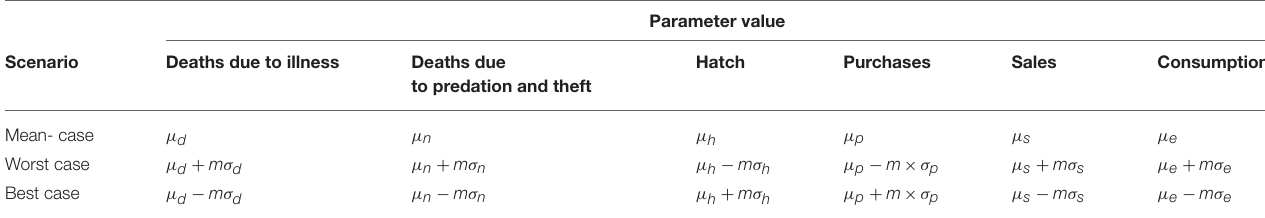
TABLE 3 | Parameter calculations for mean-case, worst-case, and best-case